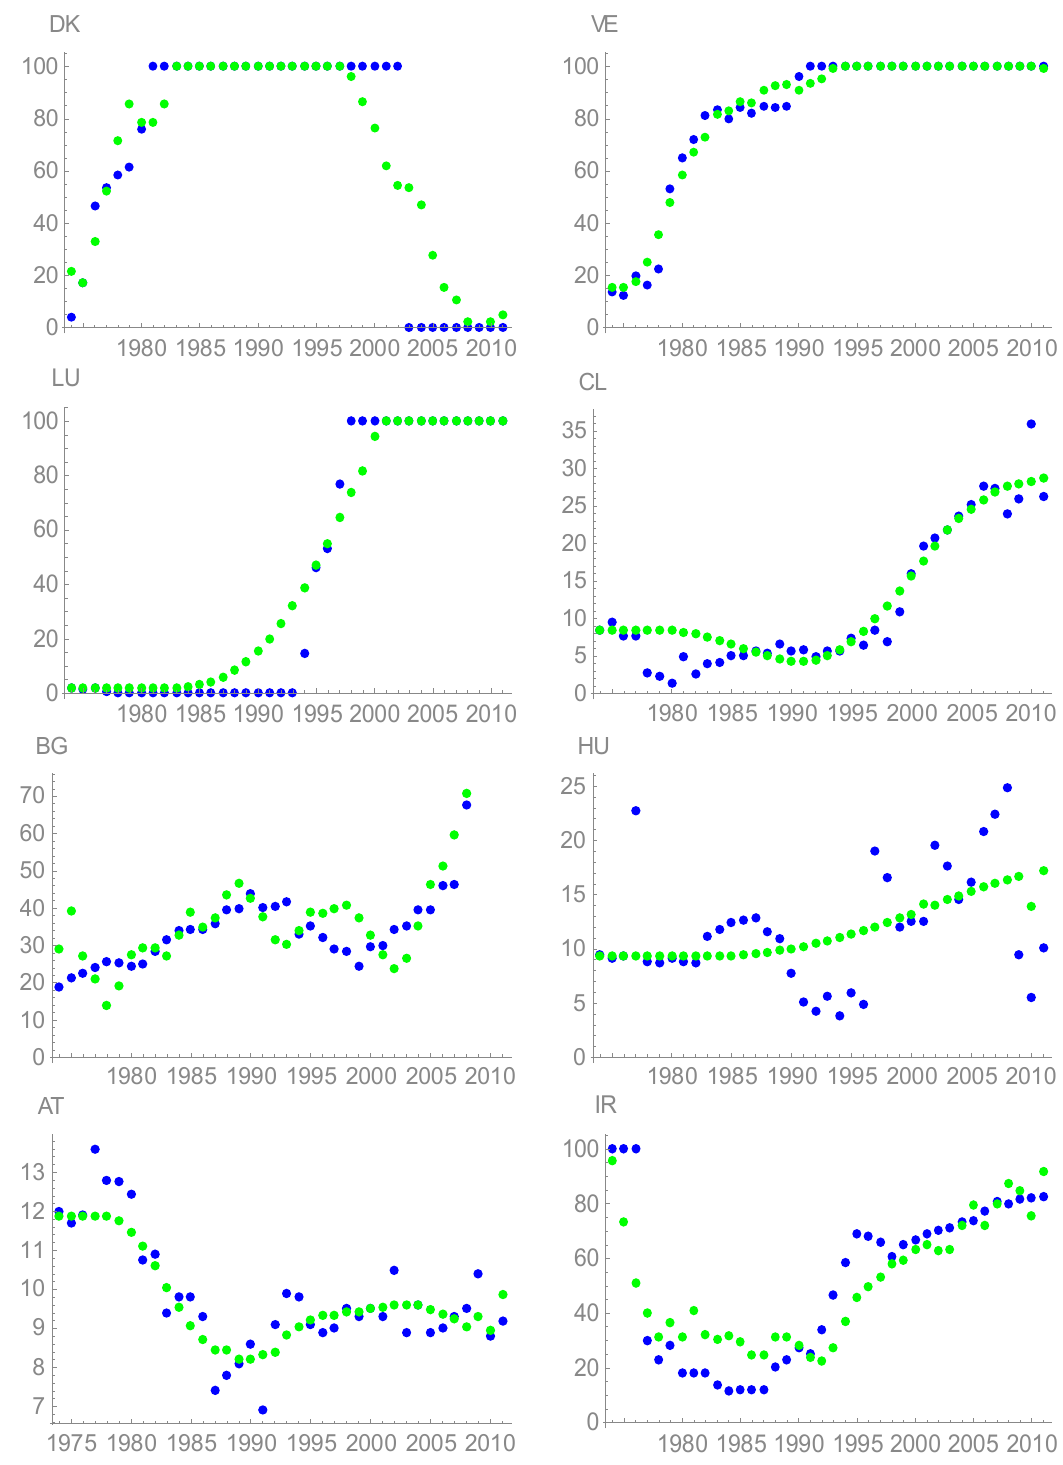
Figure A1. Adjustments provided by the model (in green) to the percentages of steel from the EAF route in the 36 countries under study (in blue).